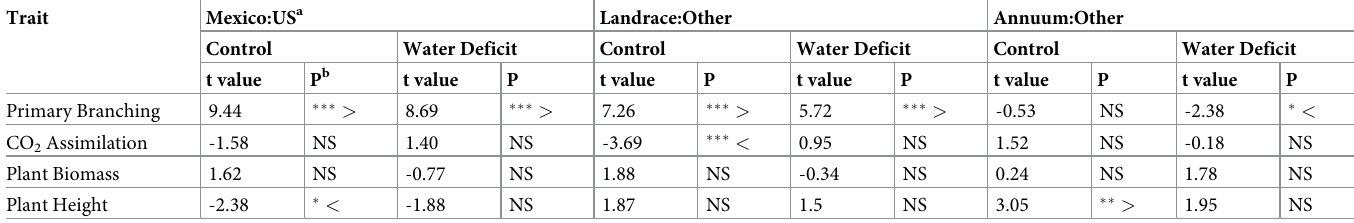
Table 4. Results of a priori group contrasts on four traits from a greenhouse soil water deficit experiment on chile pepper ( Capsicum sp.) at the Ohio State University. Trait Mexico:US a Landrace:Other Annuum:Other Control Water Deficit Control Water Deficit